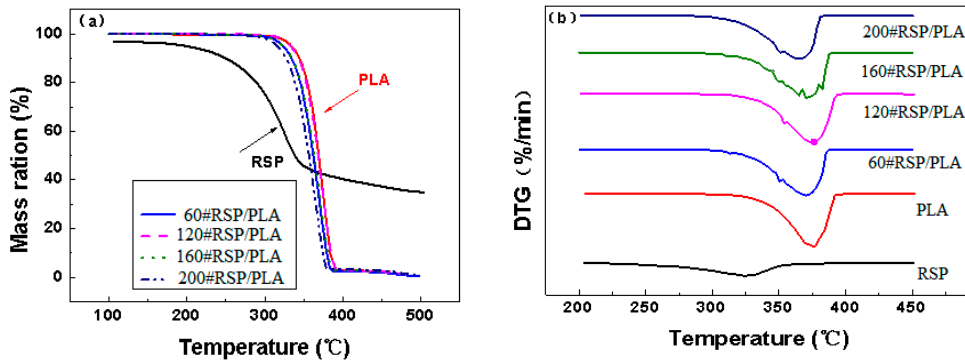
Figure 3. ( a ) TGA curves and ( b ) DTG curves for samples at 20 K/min in a nitrogen atmosphere. Table 1. Thermal decomposition parameters for 3D-printed PLA and RSP/PLA composites in a nitrogen atmosphere. Specimen